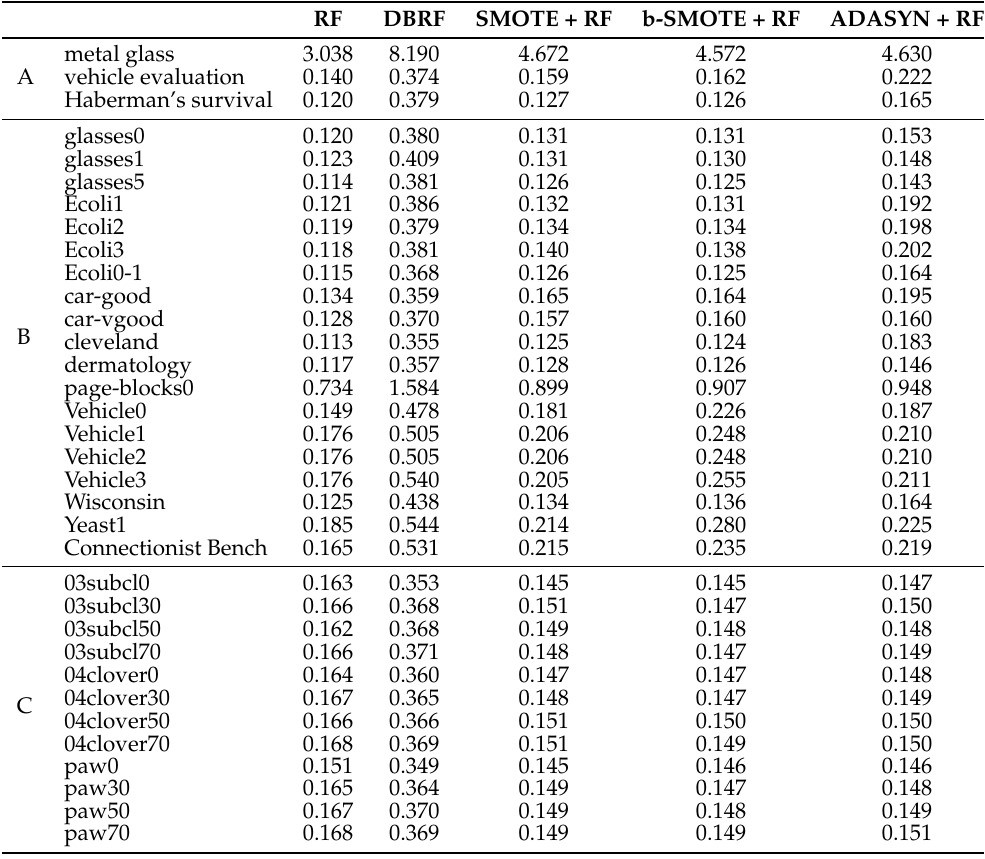
Table 4. Average time spent by the RF, DBRF, SMOTE + RF, b-SMOTE + RF, and ADASYN + RF training datasets. The results are in seconds.